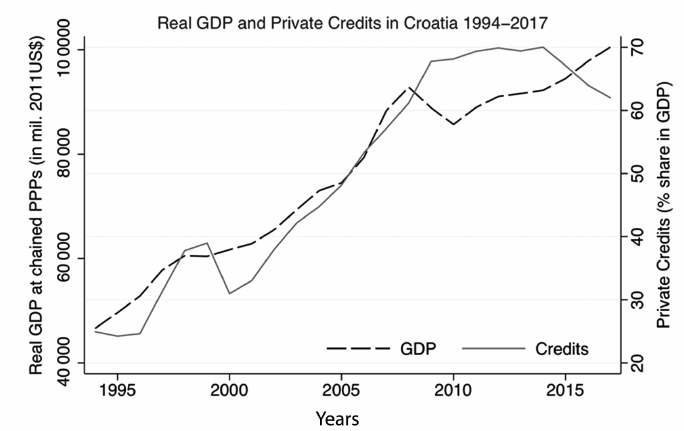
Figure 1. Output and Lending Dynamics in Croatia 1994-2017 (source: authors’ calculation)